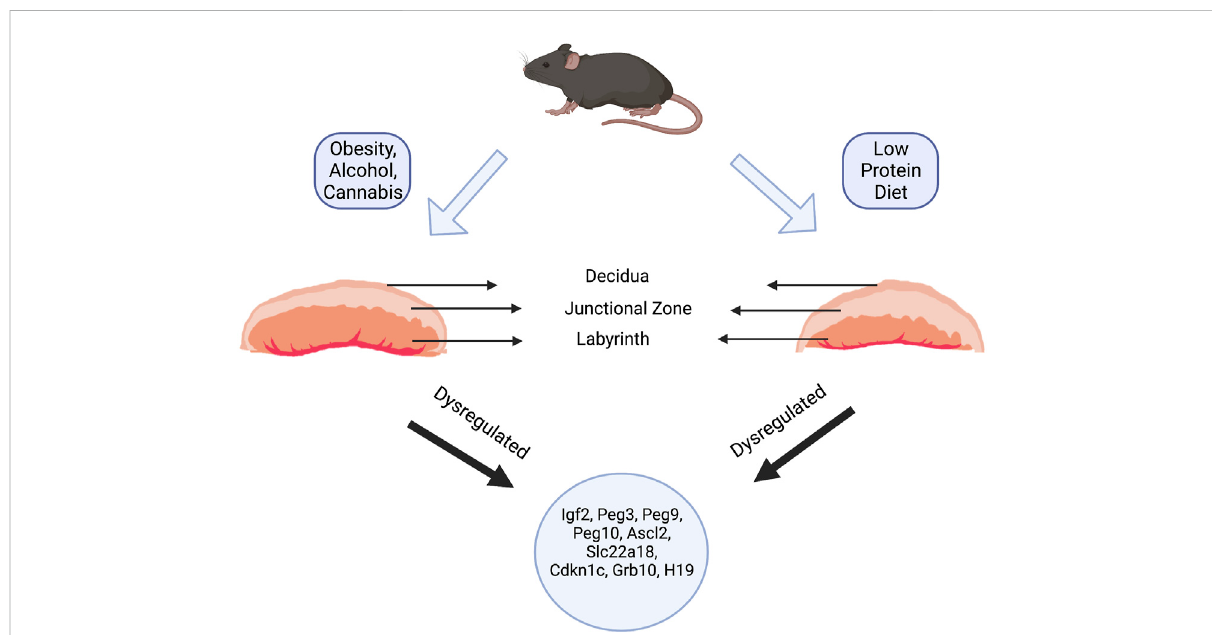
FIGURE 2 Paternal Exposure and Placental Phenotypes. Paternal exposures induce a wide variety of gross and histological placental phenotypes. For example, paternal alcohol, cannabis, and high-fat diet exposures induce increases in the labyrinth layer (layer responsible for nutrient and gaseous exchange) and decreases in the junctional zone (containing the spongiotrophoblasts and glycogen cells). In contrast, maintaining sires on a low- protein diet induced an increase in the junctional zone and a corresponding decrease in the labyrinth. Regardless of the changes to placental histology, most paternal exposures led to dysregulation of imprinted genes like Ascl2 , Igf2 , H19 , Slc22a18 , Cdkn1c , Grb10 , Mest , and Snrpn